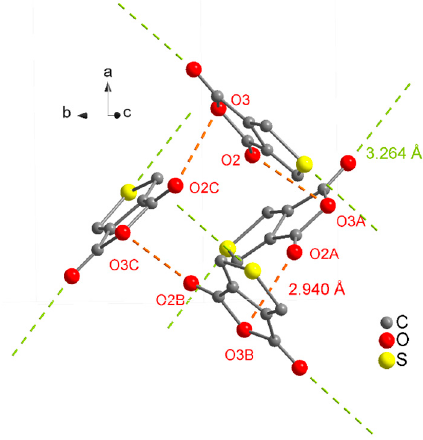
Figure 4. Intermolecular interactions within the sum of the van-der-Waals radii for compound 4 , showing the central square pattern. Symmetry operation for generating equivalent atoms: (A) y,